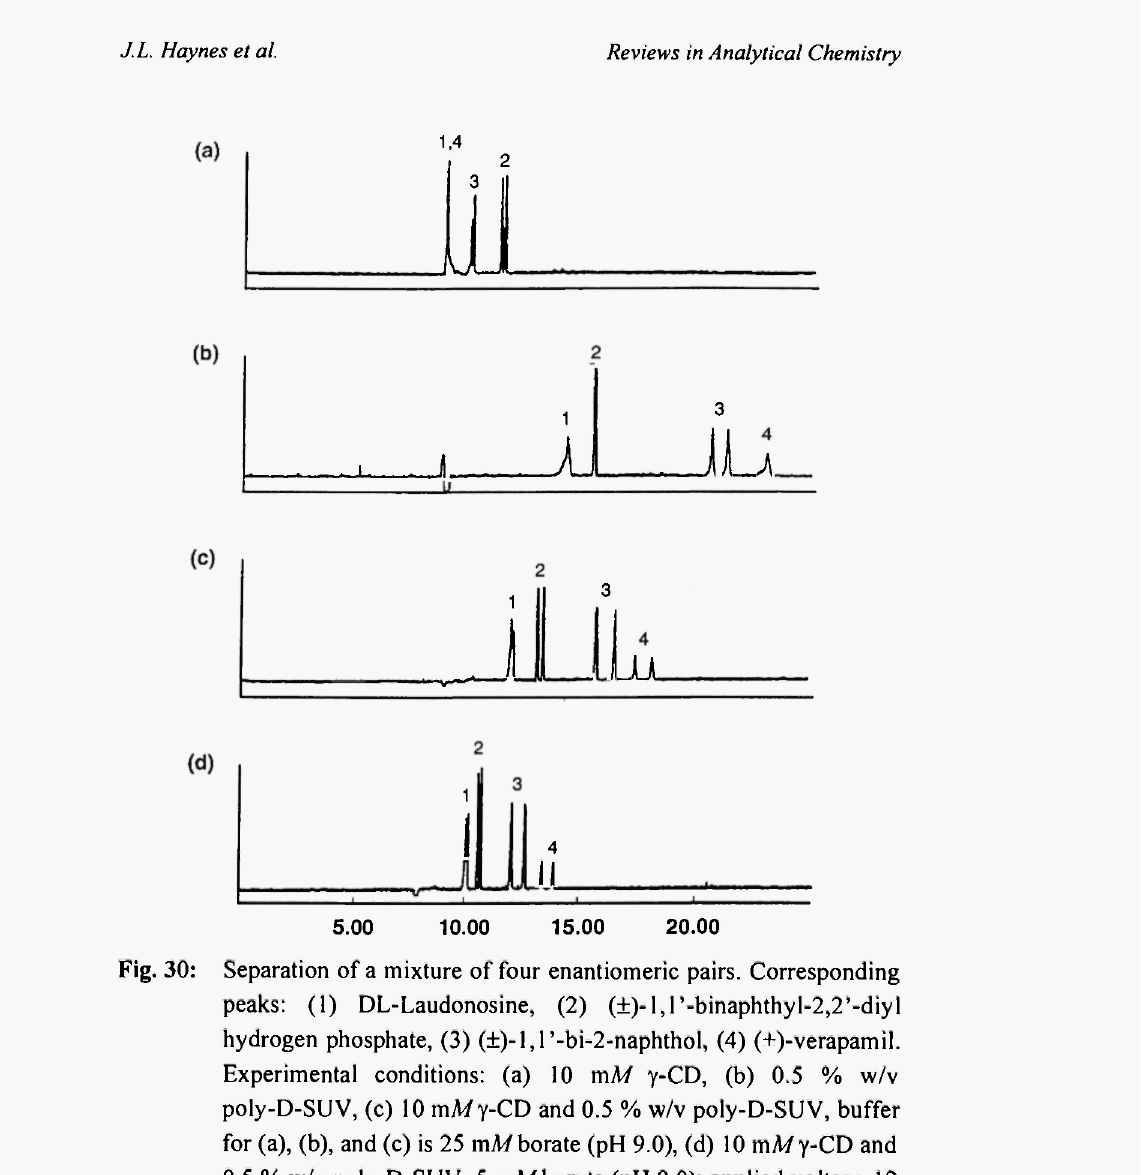
Fig. 30: Separation of a mixture of four enantiomeric pairs. Corresponding peaks: (1) DL-Laudonosine, (2) (±)-l,l'-binaphthyl-2,2'-diyl hydrogen phosphate, (3) (±)-l,l'-bi-2-naphthol, (4) (+)-verapamiI. Experimental conditions: (a) 10 mΜ γ-CD, (b) 0.5 % w/v poly-D-SUV, (c) 10 mMy-CD and 0.5 % w/v poly-D-SUV, buffer for (a), (b), and (c) is 25 mM borate (pH 9.0), (d) 10 mA/γ-CD